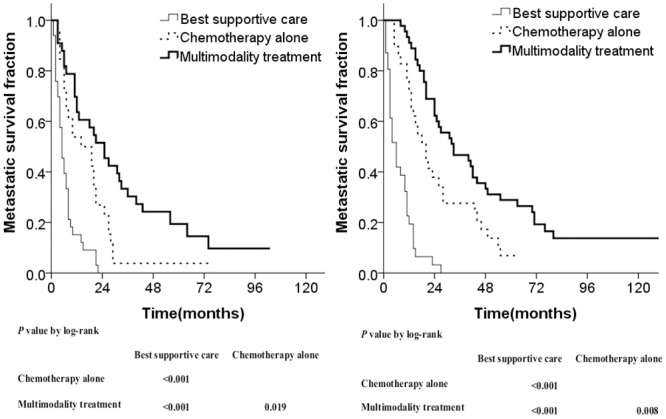
Metastatic survival curves stratified by treatment modalities in different disease-free intervals (DFI): DFI <1 year (A) and DFI >1 year (B).